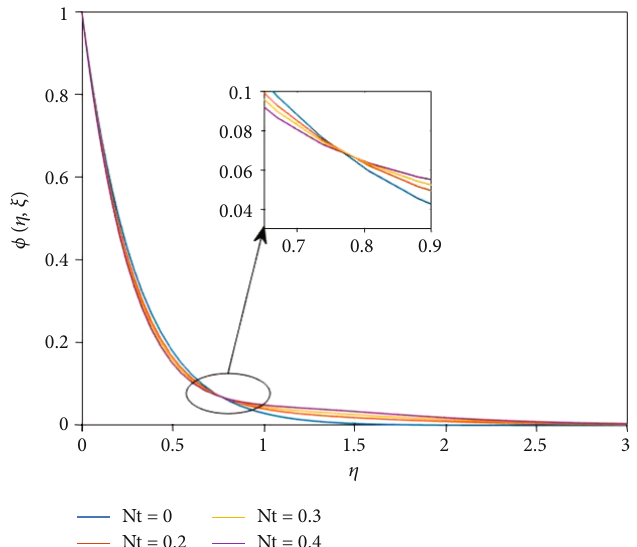
: 8, ξ = 1, N N Df = Sr = Bi = 0 : 5, He b = t = w = 0